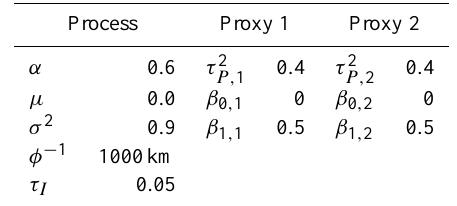
Table 1. Model parameters for the experiments. Proxy 1 is time- certain and Proxy 2 features an uncertain age–depth model. The signal-to-noise ratio is set to about 0.25 (cf. Smerdon, 2012). The measurement noise for the instrumental data is given by τ I .